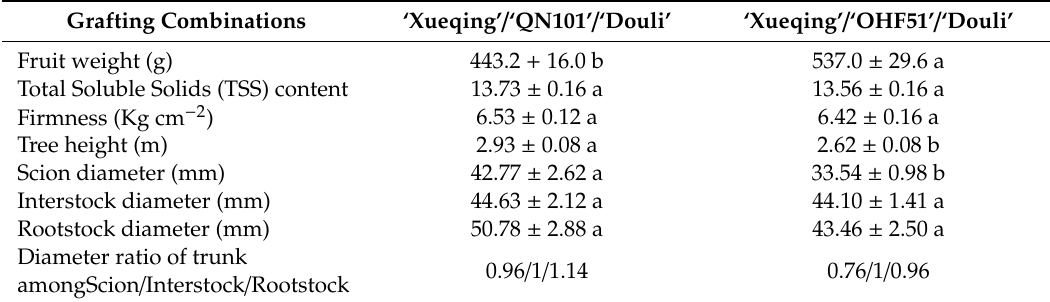
Table 1. Comparison of two types of grafting